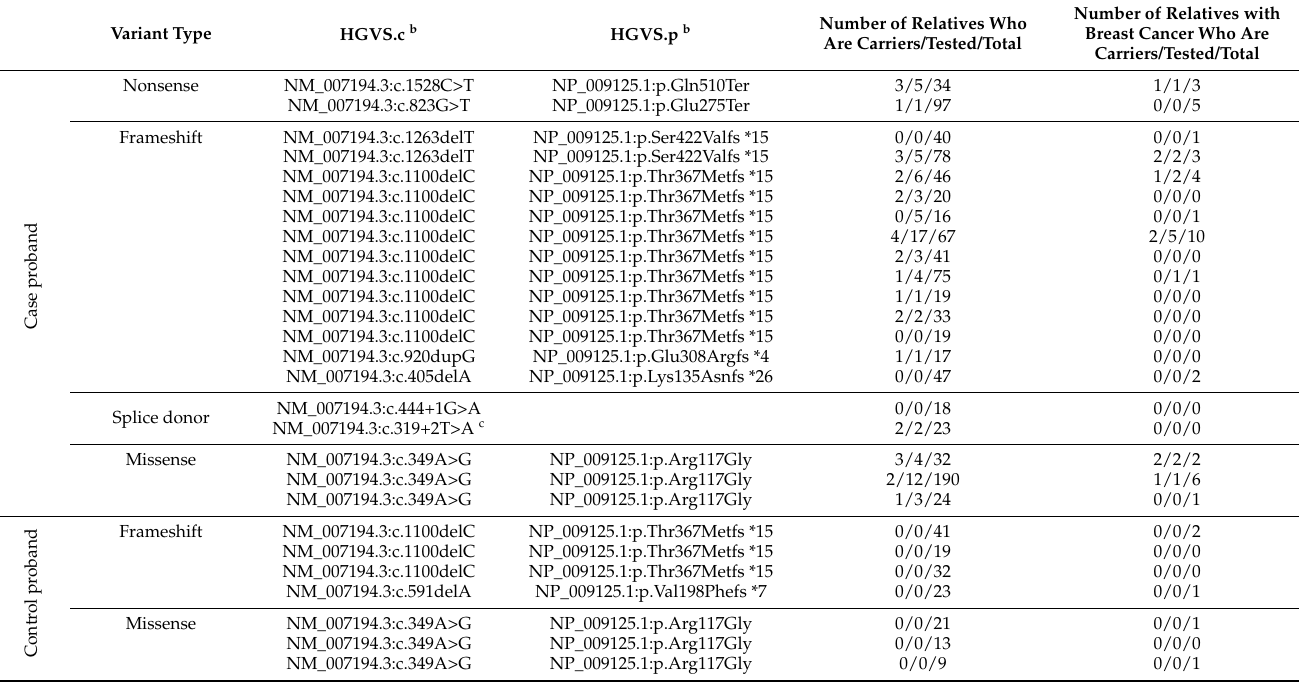
Table 1. Pathogenic and likely pathogenic a CHEK2 variants identified by targeted-sequencing in the case and control probands participating in the Australian Breast Cancer Family